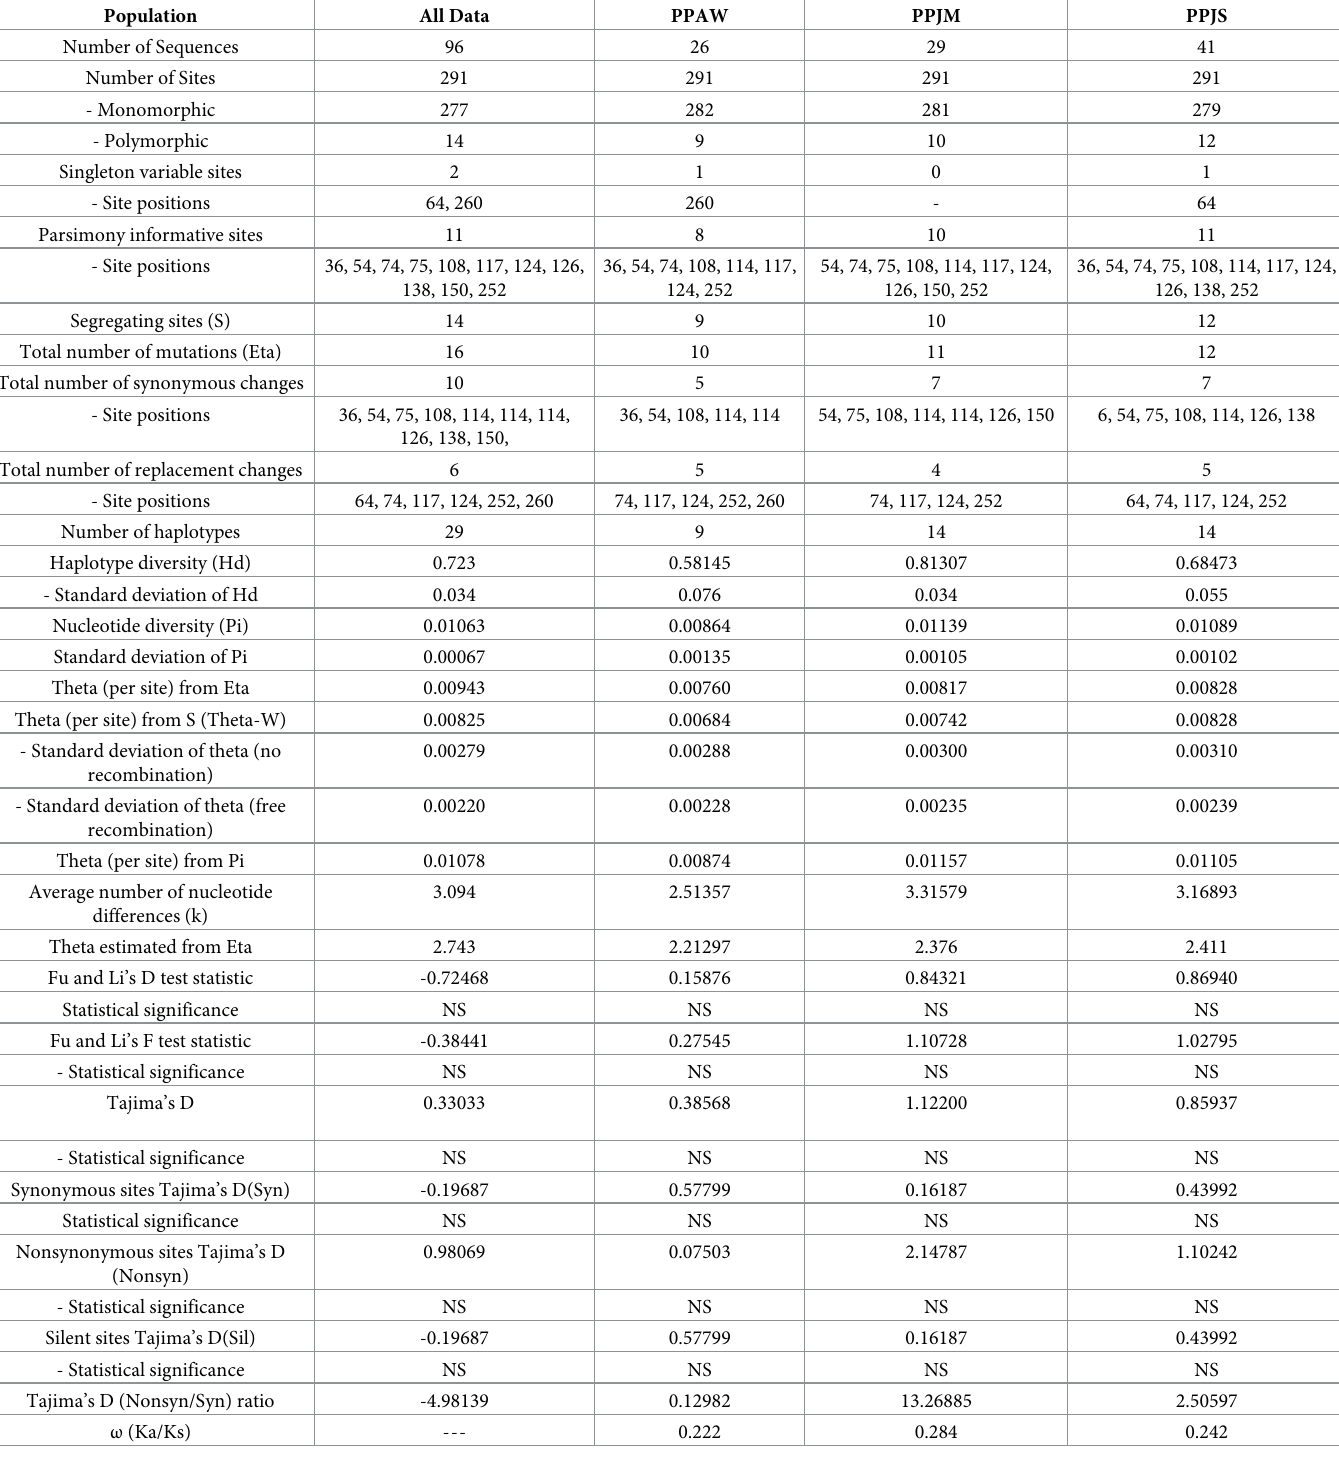
Table 2. PpSP12 population genetics analyses for P . papatasi